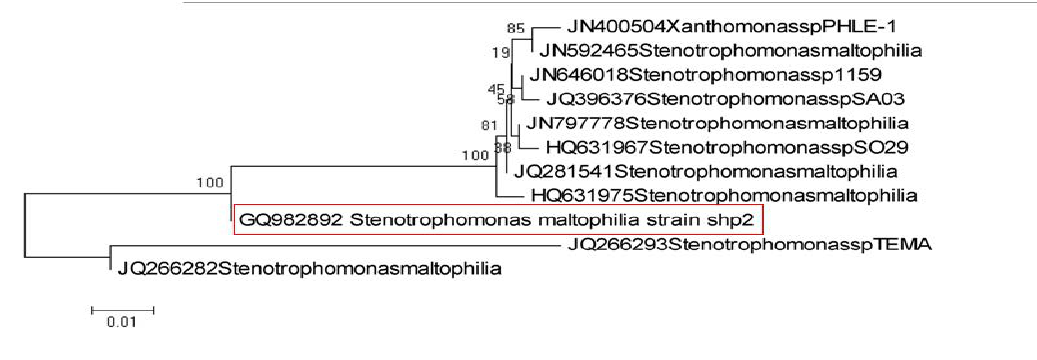
Fig. 1. Phylogenetic analysis of RAL-4